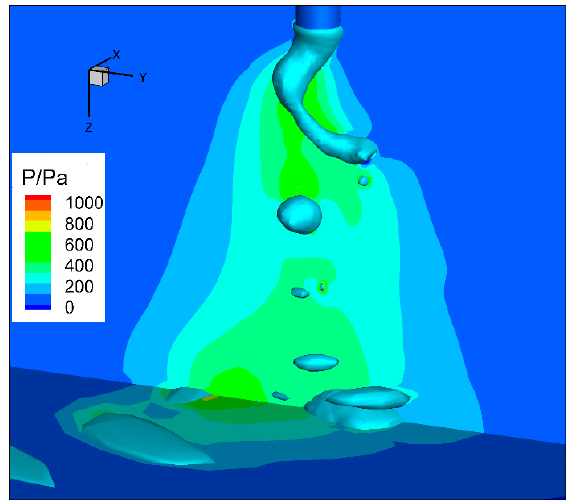
Figure 7. Arc pressure field for high-current GMAW.